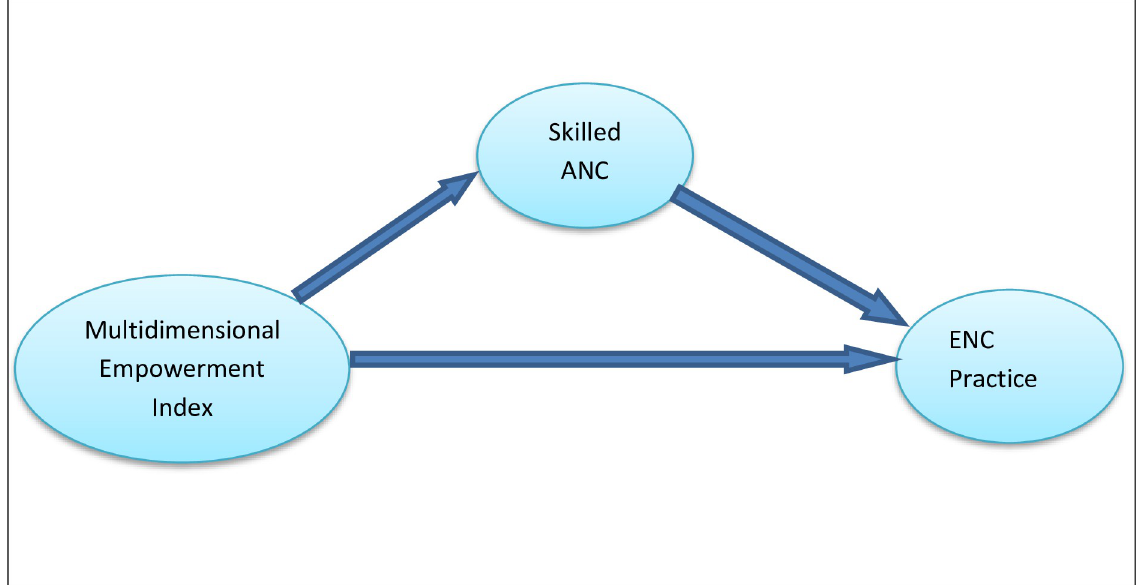
Fig 1. Conceptual path